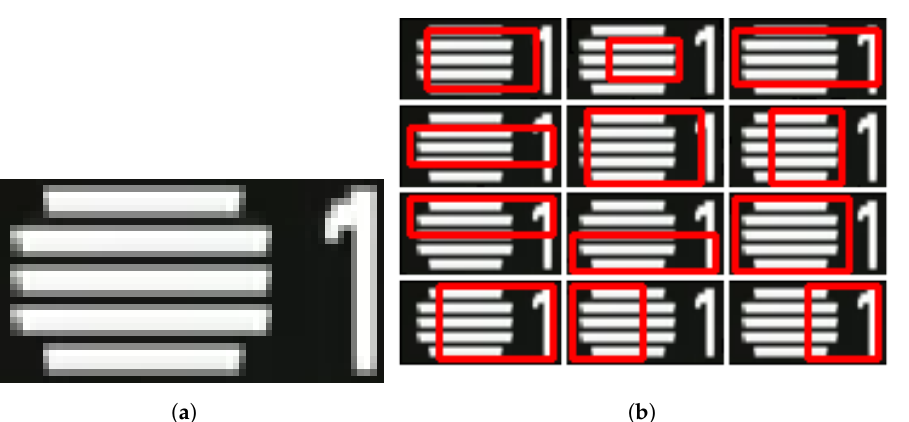
Figure 8. Example of a detected logo candidate and associated additional subregions. The reader is encouraged to visualize this image in color to better see the subregions. ( a ) Region of the validated logo candidate. ( b ) The 12 additional subregions inprinted on the base